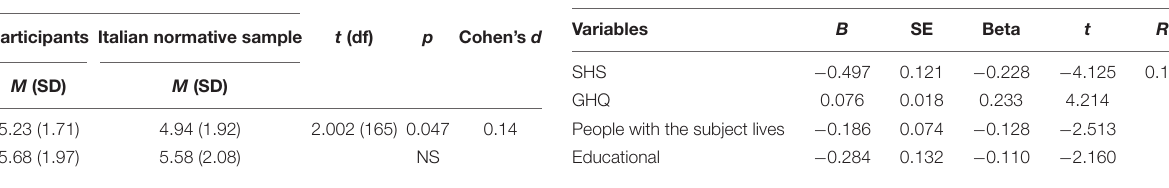
TABLE 5 | Loneliness Scale: comparison between the average values of the participants and the average values of the Italian normative sample. UCLA